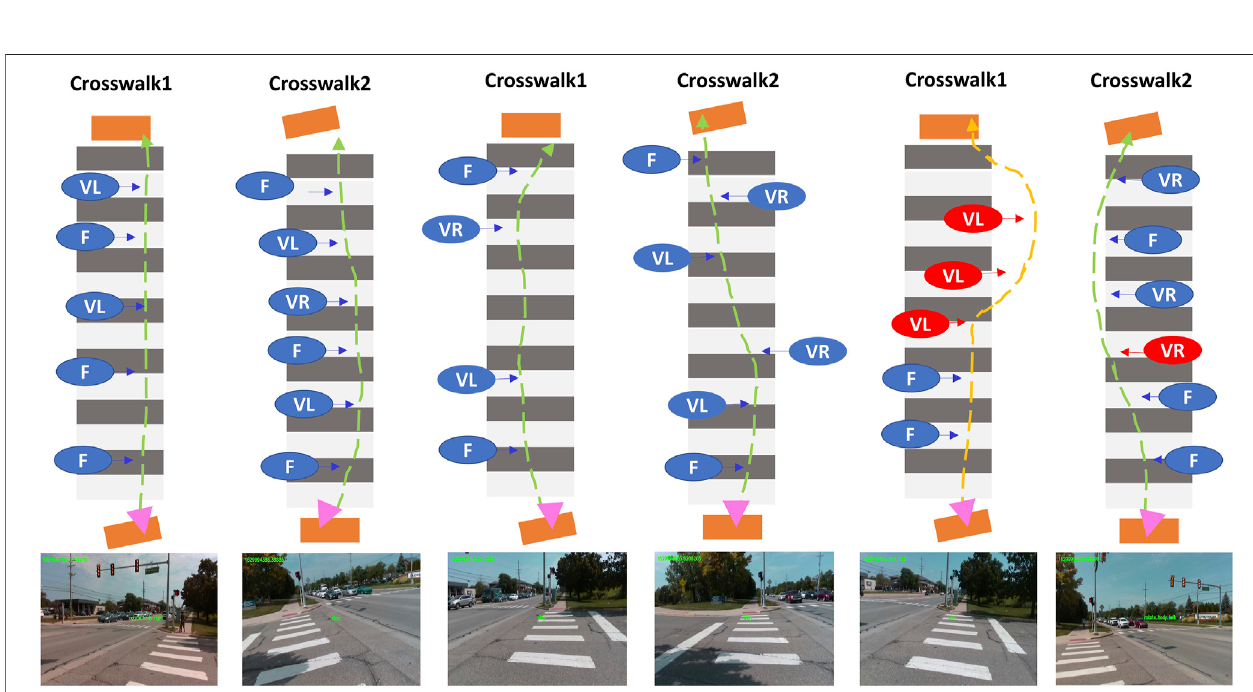
FIGURE 9 | Visualized sampled and simpli fi ed results of participants. Two different crosswalks are symbolized and two of each are assigned to each subject in order of S010, S009, and S008.